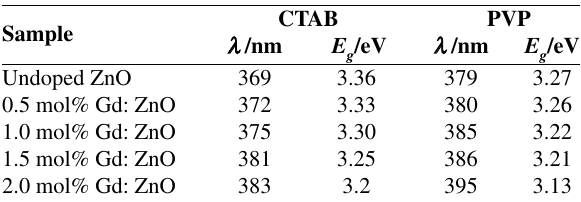
Table 4. Absorption wavelength and calculated bandgap of undo- ped and Gd doped ZnO. Sample